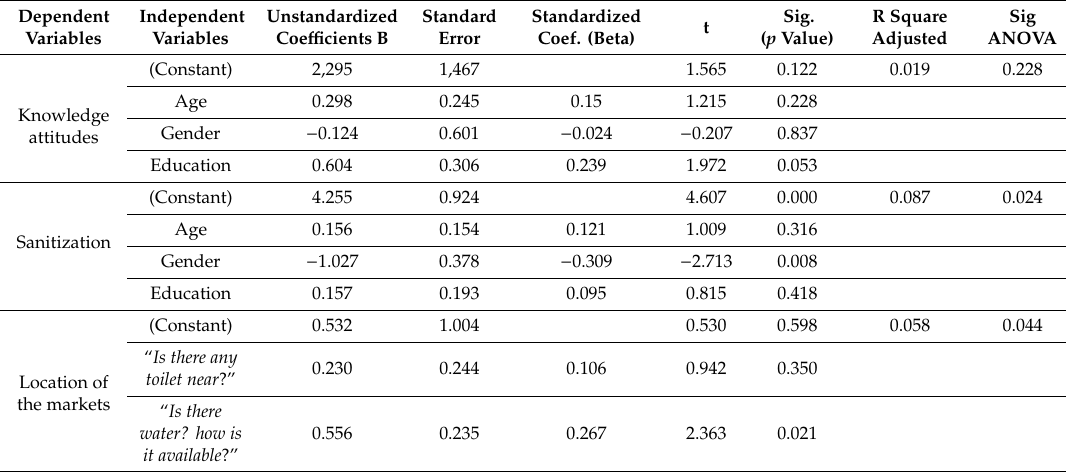
Table 3. Multivariable analysis comparing vendor’s profile (age, gender and education) against their knowledge of good hygiene practices and sanitization and comparison of markets location and distribution of management resources